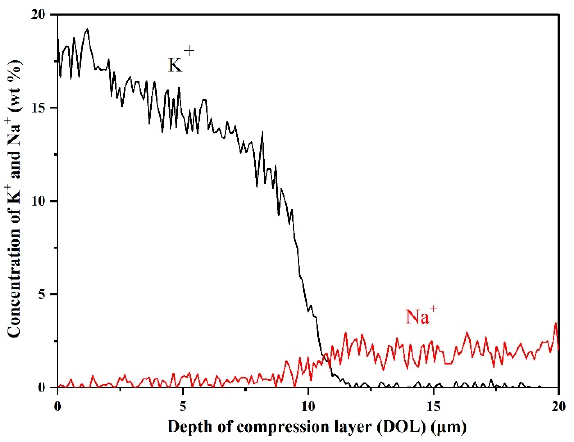
Figure 5. K + and Na + concentration distribution in T2 LAS GCs after ion-exchange at 420 °C for 2